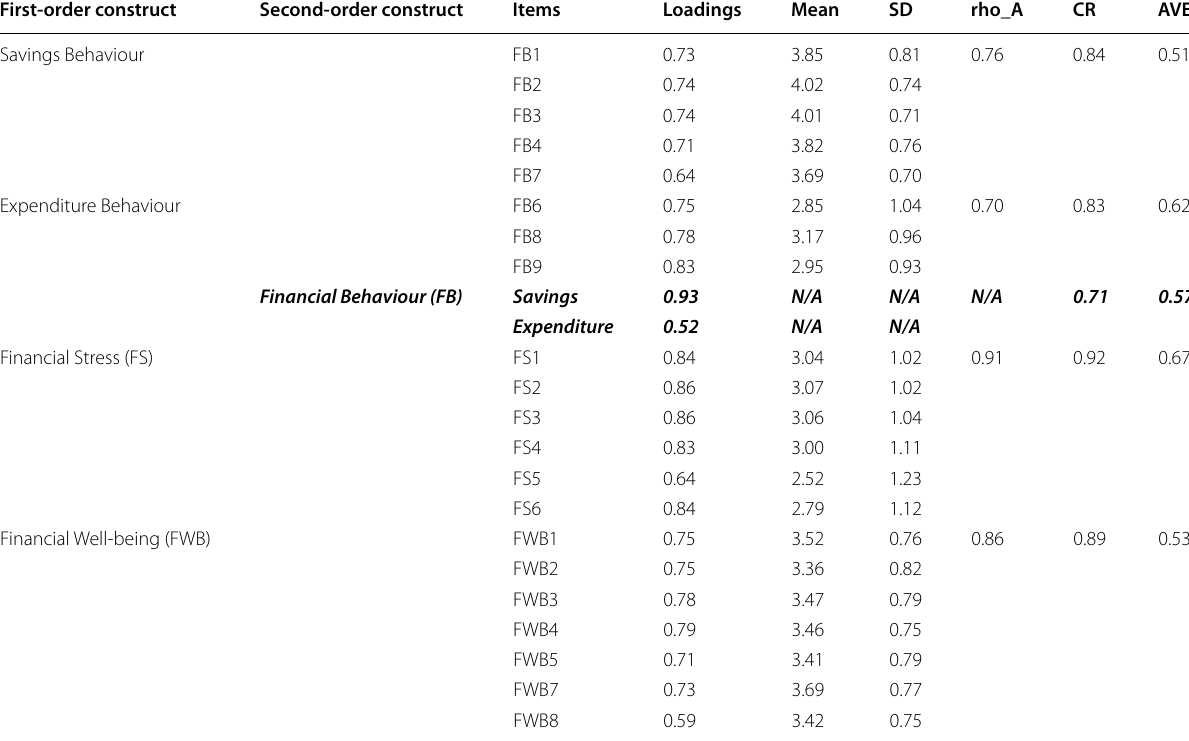
Table 5 Reliability and convergent validity of the measurement model